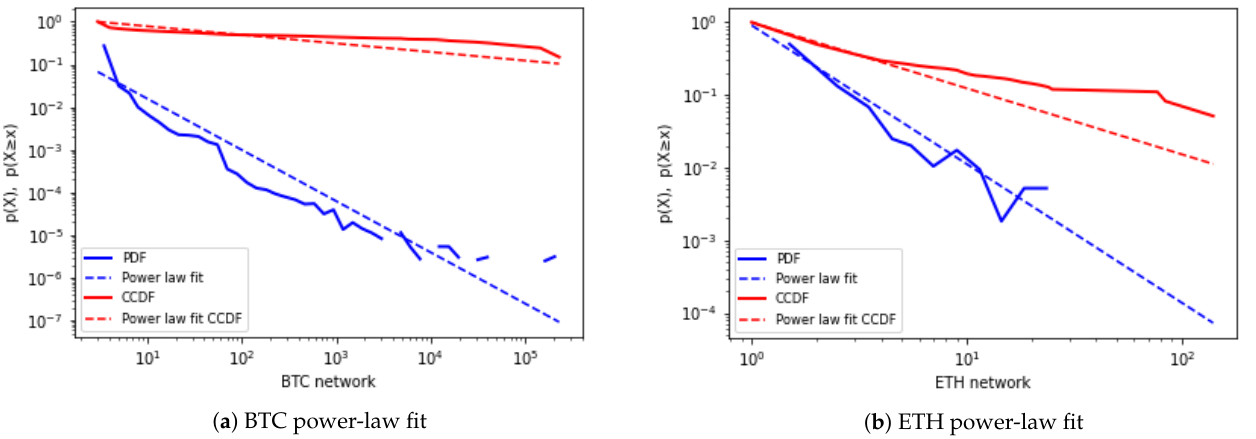
Figure 13. Power-law fit using Python powerlaw library by Alstott et al. BTC and ETH